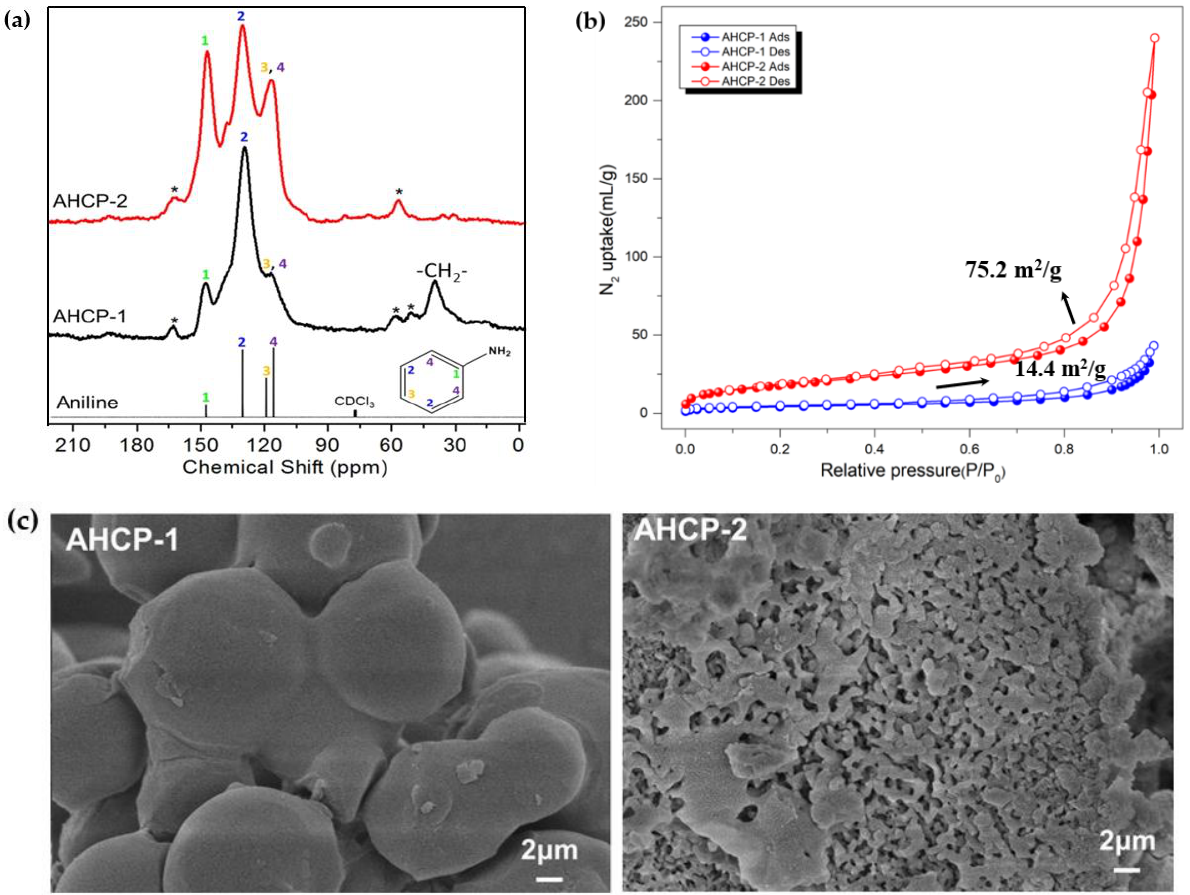
Figure 1. ( a ) The solid state 13 C NMR spectra of AHCP-1 and AHCP-2 and 13 C NMR spectrum of aniline; asterisks denote spinning sidebands. ( b ) Nitrogen adsorption–desorption isotherms and pore diameter at 77 K of AHCP-1 and AHCP-2. ( c ) The SEM micrographs of AHCP-1 and AHCP-2.